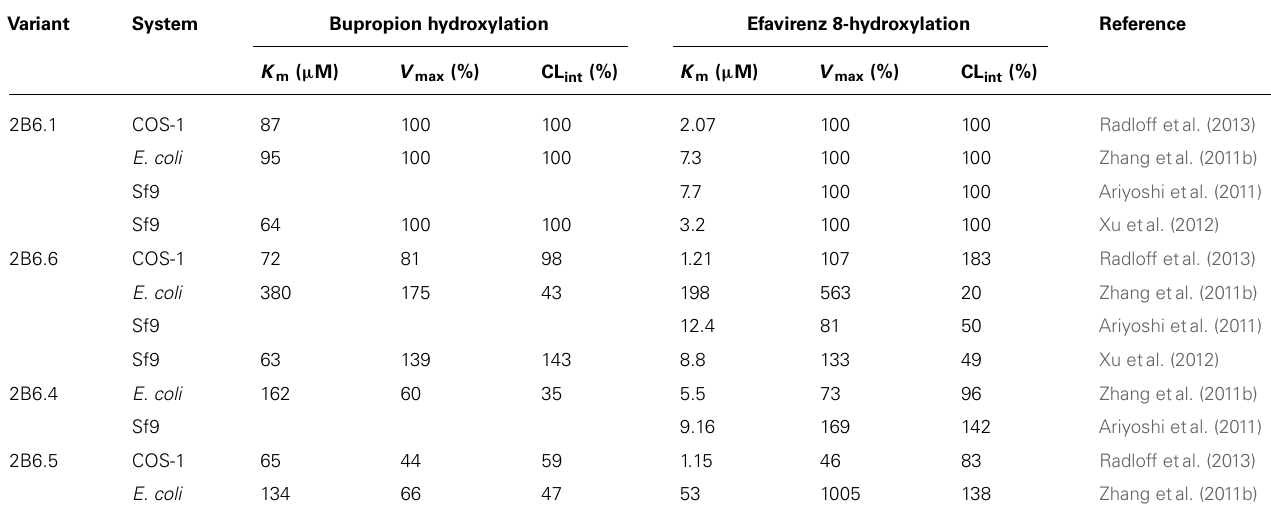
Table 2 | Kinetic properties of recombinantly expressed CYP2B6 protein variants with bupropion and efavirenz. Variant System Bupropion hydroxylation Efavirenz 8-hydroxylation